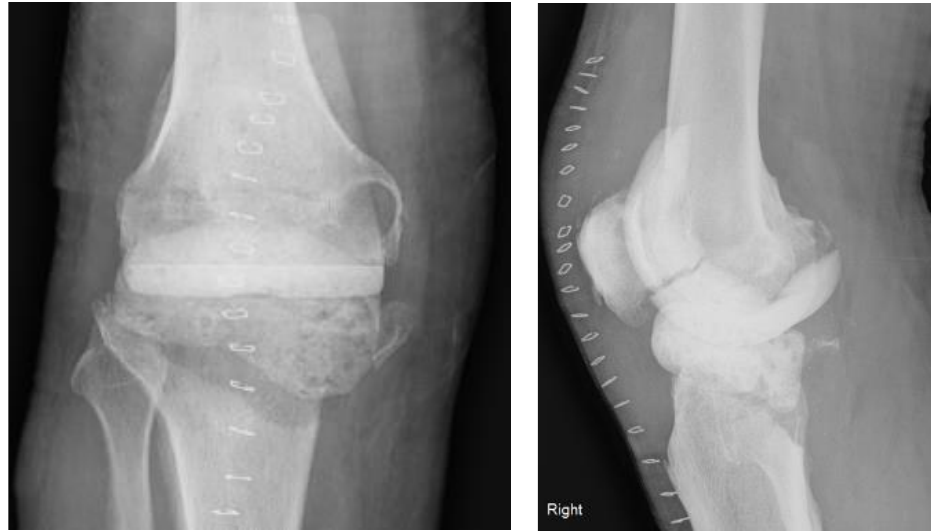
Figure 2. AP and lateral radiographs of antibiotic spacer.